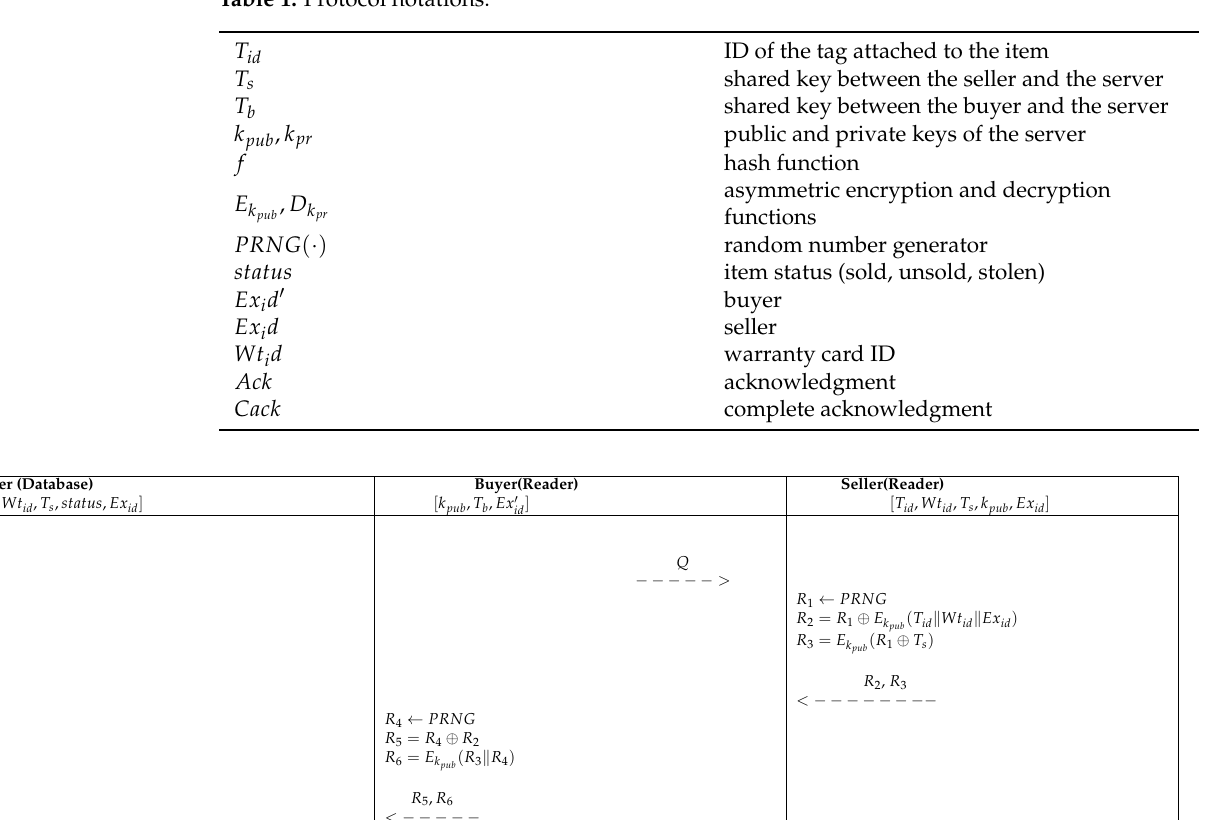
Table 1. Protocol notations.